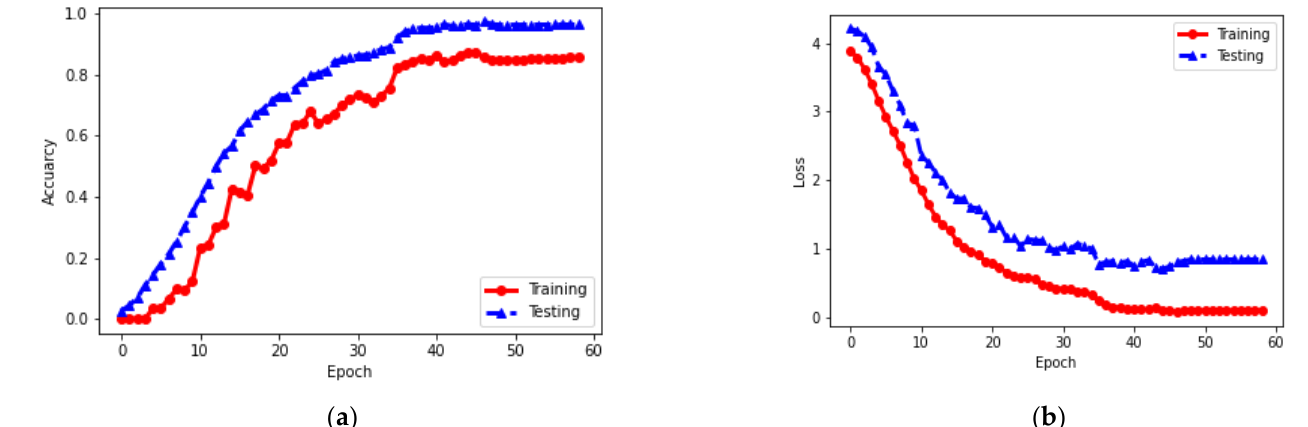
Figure 2. Performance accuracy and loss curves over epoch on the CCAT50 dataset: ( a ) accuracy; ( b ) loss.